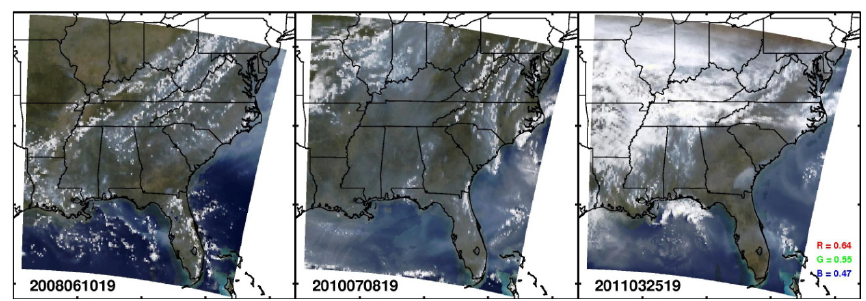
Figure 3 Fig. 3. The simulated RGB imagery viewed from GOES-R on 10 June 2008 (left), 8 July 2010 (middle), and 25 March 2011 (right).